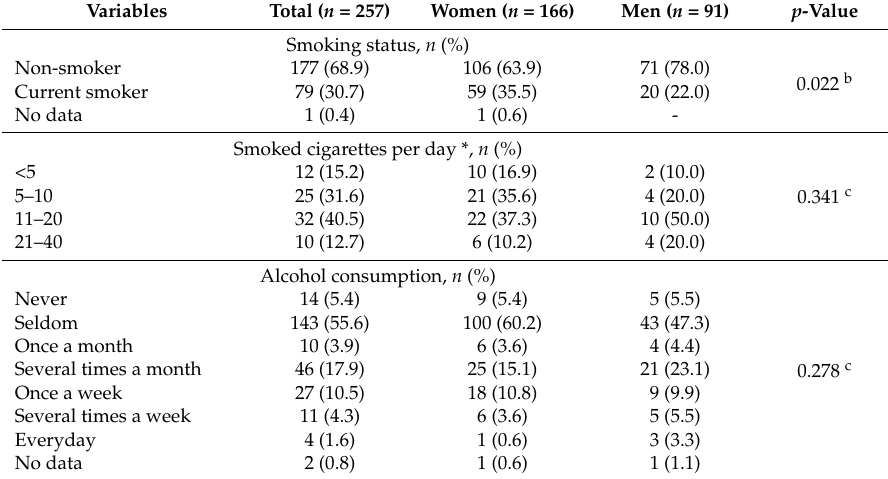
Table 2. Frequency of cigarette smoking, alcohol consumption, physical activity, body mass index (BMI), and religiosity categories in immigrants of Polish origin in